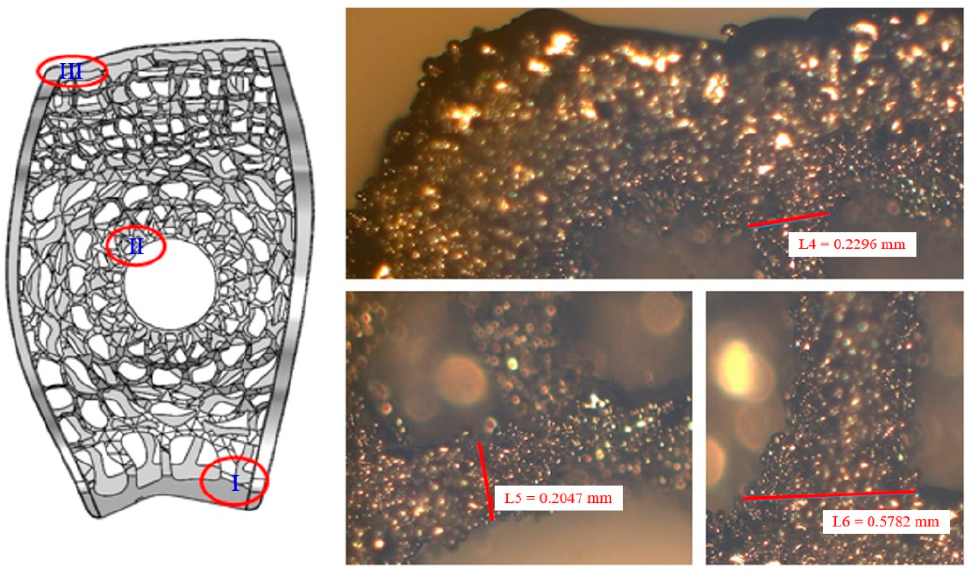
Figure 9. The scanning electron microscope (SEM) photograph for specimens.